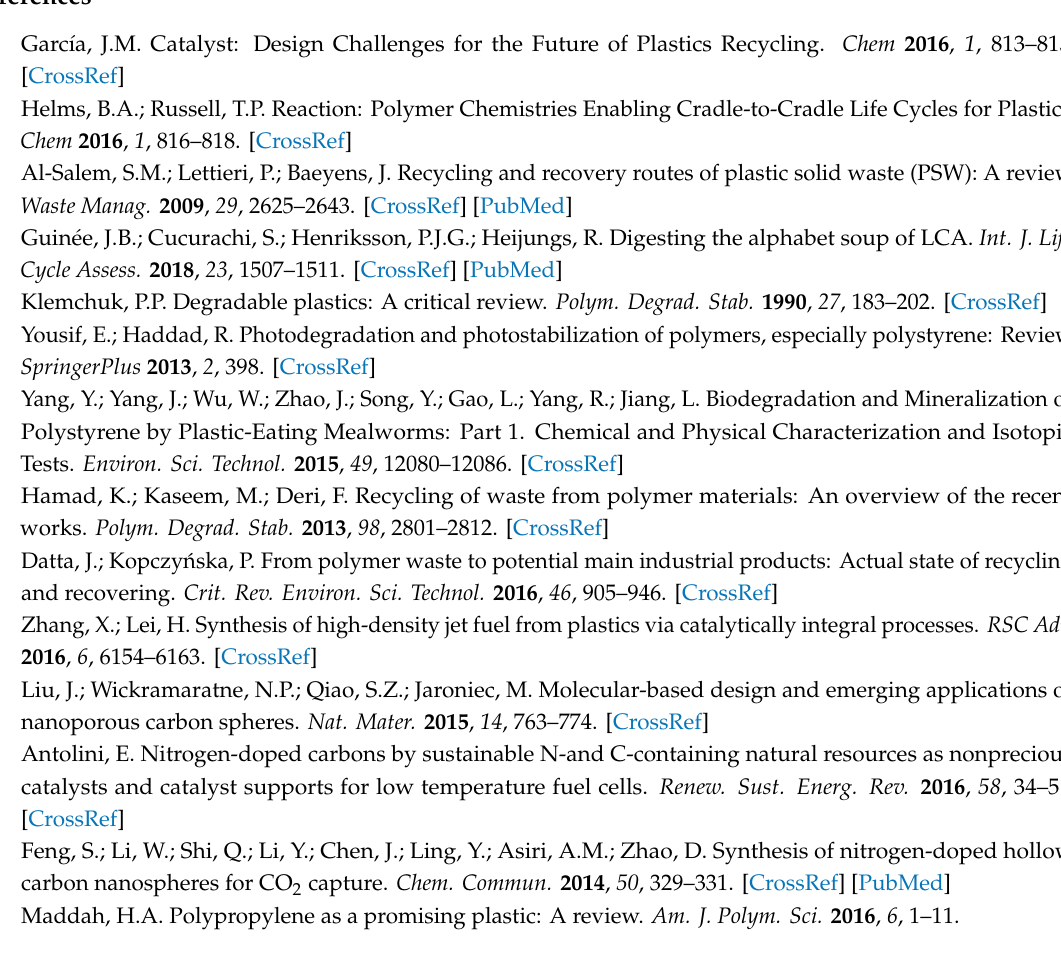
Figure S1: (A) Schematic of the apparatus (modified form from ref [21]), (B) Schematic view of the two stage based CVD furnace used for the synthesis of CSs from polypropylene (a) SCSs, (b) Si@CSs and (c) Si@NCSs. Figure S2: Diameter distribution of (a) SCSs, (b) HCSs and (c) and NHCSs. Figure S3: High resolution XPS data for (a) C1s and (b) O1s XPS spectra of HCS sample. Figure S4: High resolution XPS data for (a) C1s, (b) N1s and (c) O1s XPS spectra of NHCS sample. Figure S5: High resolution XPS data for (a) C1s and (b) O1s XPS spectra of SCS sample. Table S1: Summary of XPS data. Table S2: XPS component peak positions. Table S3: Summary of % concentration of all bonds in the